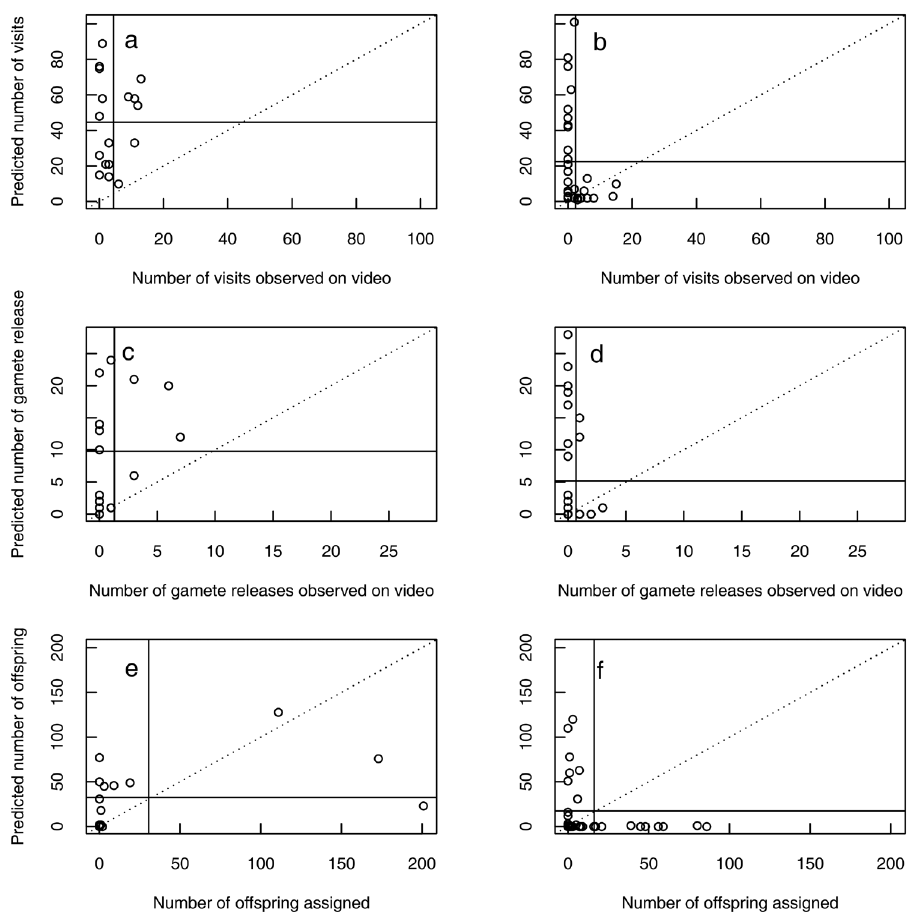
Figure 4. Predictions based on the joint posterior distributions of model parameters, against values ob- served in the raw data for the number of visits ( a, b ), the number of gamete releases ( c, d ) and the number of offspring ( e, f ) for brown trout males ( a, c, e ) and females ( b, d, f ). For each panel, solid lines indicate the mean of each variable, and the dashed line has intercept zero and slope one, which would correspond to a perfect correspondence between observed and predicted